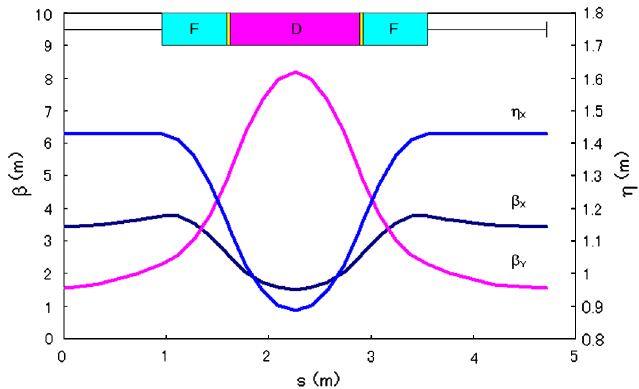
FIG. 12. Beta functions and dispersion function.